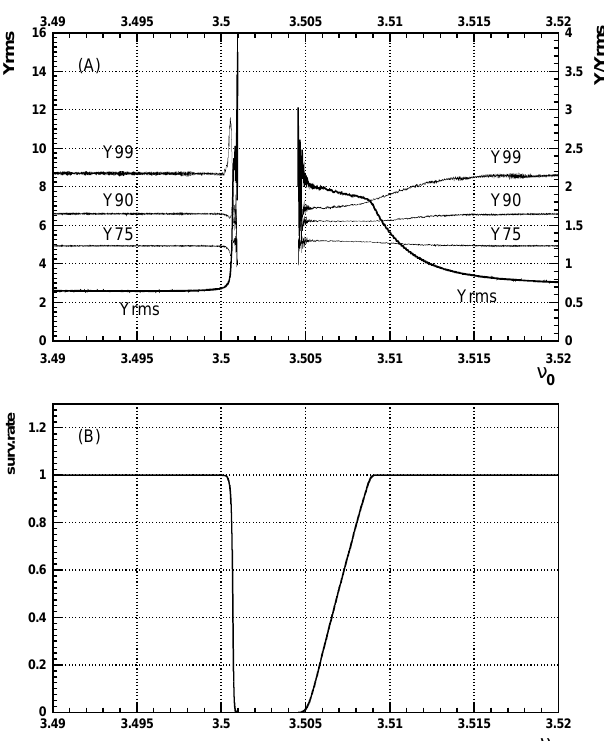
FIG. 11. (A) Ratio of 99%, 90%, and 75% beam sizes relative to the rms size in a simulation with a large aperture limit. The initial distribution is parabolic. The absolute values of the rms sizes are also shown. (B) Fraction of the survival